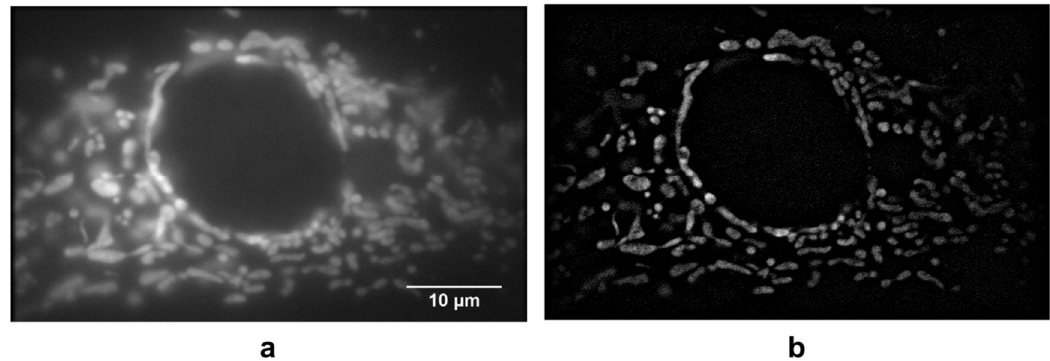
Figure 6. MCF-7 breast cancer cells incubated with the mitochondrial marker R123 (5 µM, 30 min) wide field image ( a ) and SIM image ( b ) (evaluated by R. Heintzmann, IPHT Jena); excitation wavelength: λ 0 = 488 nm; detection range: λ D ≥ 515 nm; Plan Neofluar 40×/1.30 oil immersion objective lens.